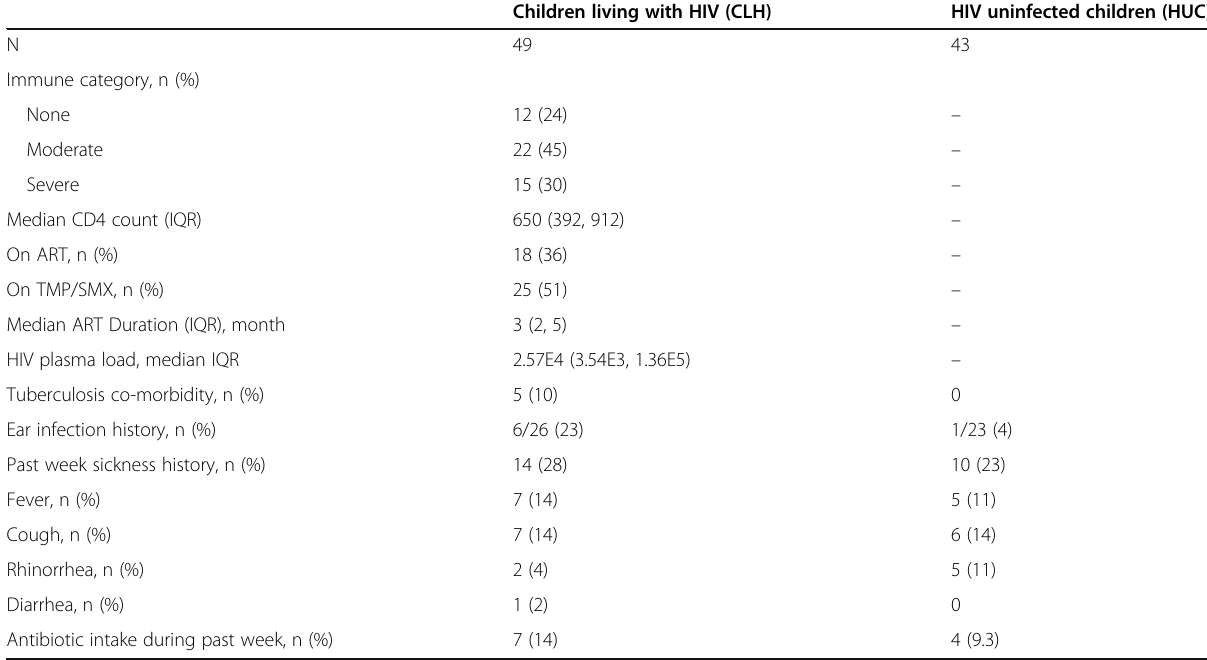
Table 2 Clinical history of children living with and without HIV Children living with HIV (CLH) HIV uninfected children